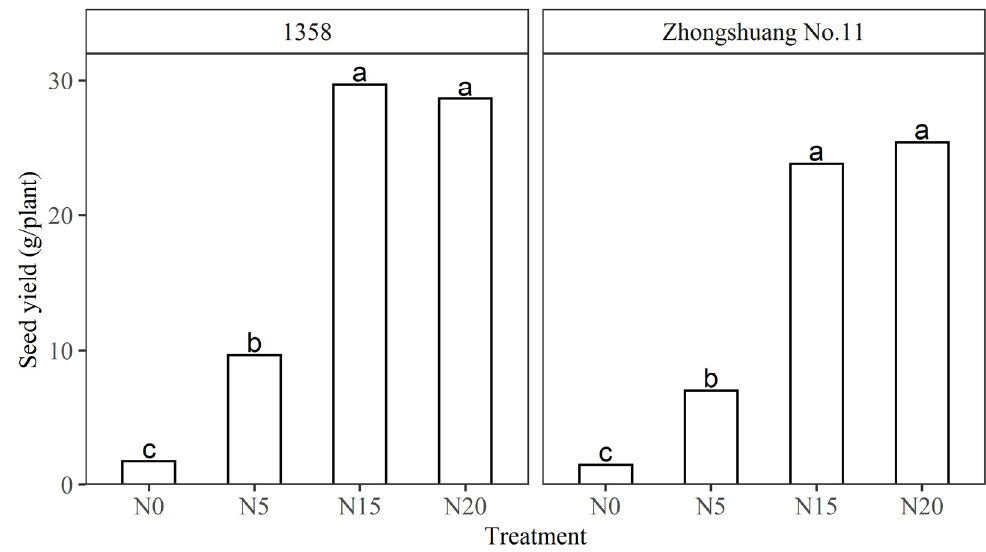
Figure 4. The seed yield of “1358” and “Zhongshuang No. 11” under different nitrogen application rates. N0, N5, N15, and N20 represent the nitrogen application rates at 0 kg ha − 1 , 75 kg ha − 1 , 225 kg ha − 1 , and 375 kg ha − 1 , respectively. Different letters indicate significant differences among nitrogen application treatments at P ≤ 0.05 by LSD.